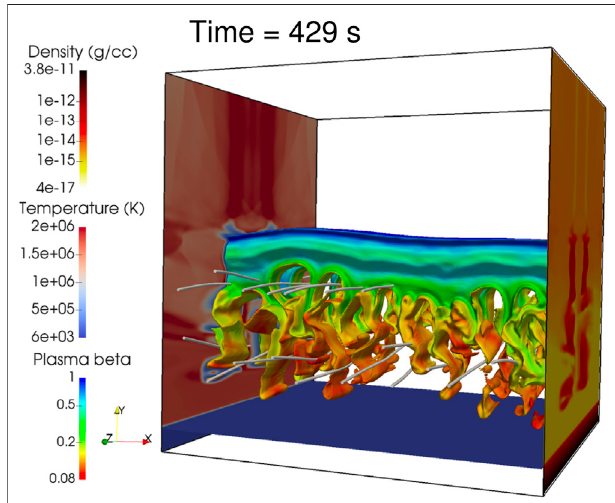
FIGURE 7 | A 3D view of a snapshot of the simulations by Xia and Keppens (2016) on the RTi development in a two-layer prominence. The snapshotshowsalaterstageoftheevolutiondeepintothenonlinearregimeof the instability. Adapted from Xia and Keppens (2016). © AAS. Reproduced with